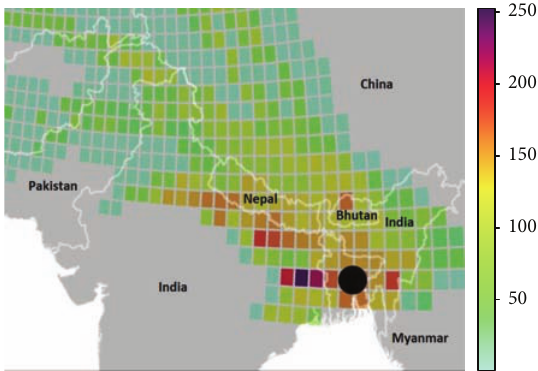
Figure 7: Gridded back trajectory concentrations showing mean PM 2.5 concentrations ( 𝜇 g m −3 ), using CWT